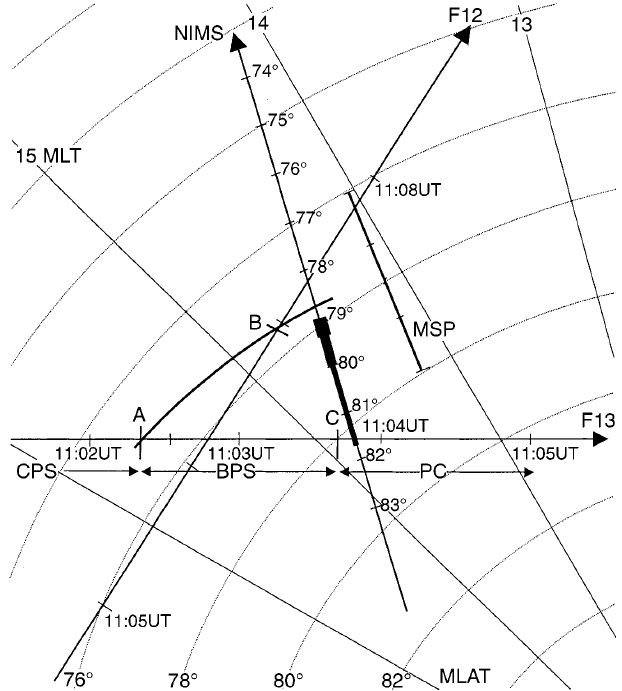
Fig. 4. Diagrammatic representation of the DMSP tracks, the NIMS satellite tomography image plane, and the scan of the meridian scanning photometer ( MSP ) in the altitude-adjusted CGM latitude versus MLT plane. The locations of the CPS/BPS boundary are marked by the letters A and B on the respective DMSP tracks, with C denoting the BPS/polar cap ( PC ) transition seen by satellite F-13. The locations of the structures in electron density are marked by the broadenings of the line on the image plane, with the widest segment near 79 (cid:176) N corresponding to the feature extending down to